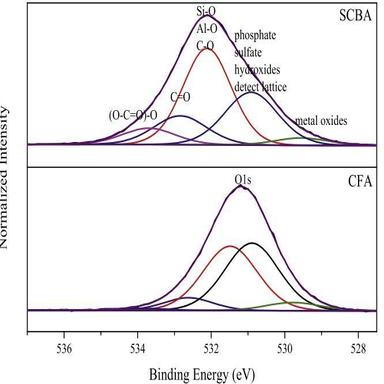
High-resolution O1s XPS spectra of the SCBA and CFA.